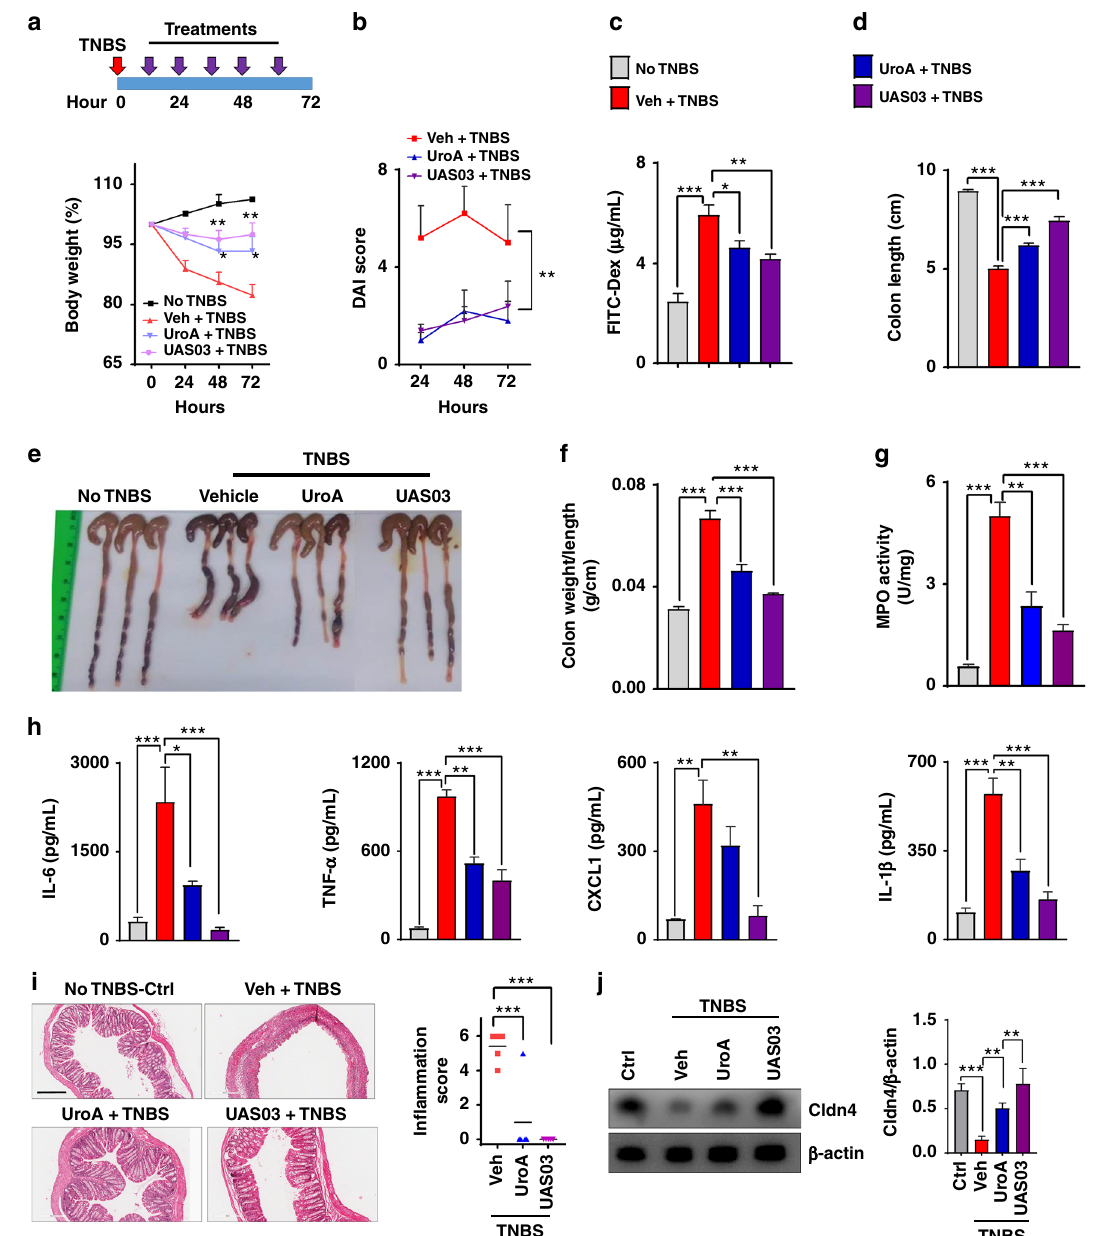
Fig. 4 UroA/UAS03 treatment attenuates TNBS-induced colitis in mice. Colitis was induced by intrarectal administration of TNBS (2.5 mg/mouse) in C57BL/6 (8 week age old, n = 5/group) mice. Mice were orally treated with vehicle or UroA (20 mg/kg) or UAS03 (20 mg/kg body weight) every 12 h post-TNBS instillation for 60 h and the experiment terminated at 72 h. Representative data from one of three independent experiments is shown. a Percent body weight loss (No TNBS- Solid black line; Veh + TNBS- Solid red line; UroA + TNBS- Solid blue line; UAS03 + TNBS- Solid purple line). b disease activity index, c intestinal permeability, d colon lengths were measured. e Gross morphological changes of colon, f ratio of colon weight/length, g colonic myeloperoxidase (MPO) levels, h serum IL-6, TNF- α , CXCL1, and IL-1 β levels, i microphotographs of hematoxylin and eosin (H&E) stained sections of colons and in fl ammation scores are shown. Scale bar indicates 300 μ m. j Cldn4 expression in the colons of these mice ( n = 3) was measured by immunoblots and quanti fi ed. Statistical analysis was performed (unpaired t -test) using Graphpad Prism software. Error bars, ±SEM *** p < 0.001; ** p < 0.01 * p < 0.05. Source Data are provided as a Source Data File